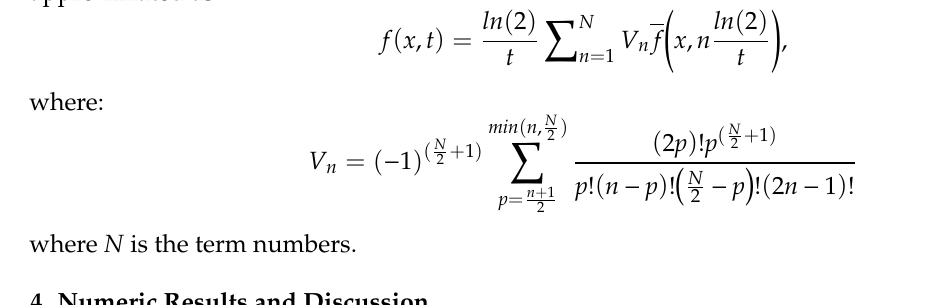
Figure 2. Variations of heat conduction with respect to the distance for various values of (cid:1837) (cid:2869) . Figure 3. Variations of carrier density with respect to the distance for various values of (cid:1837) (cid:2869) . Figure 4. Variations of displacement with respect to the distance for various values of (cid:1837) (cid:2869) .